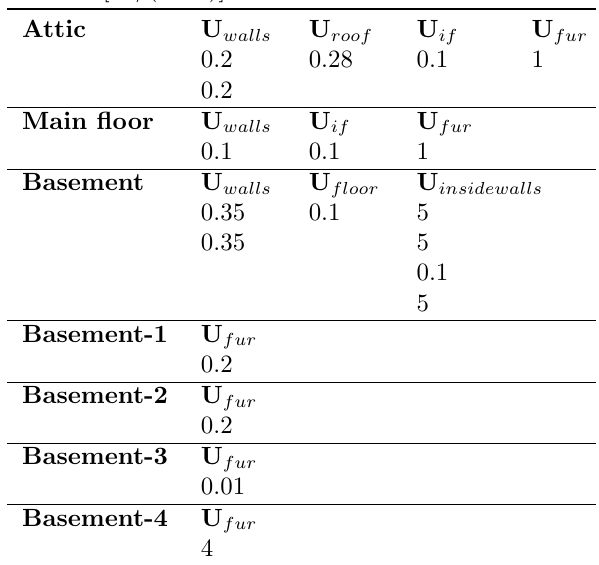
Table 6: Parameter specification in the multi-room model - Overall heat transfer